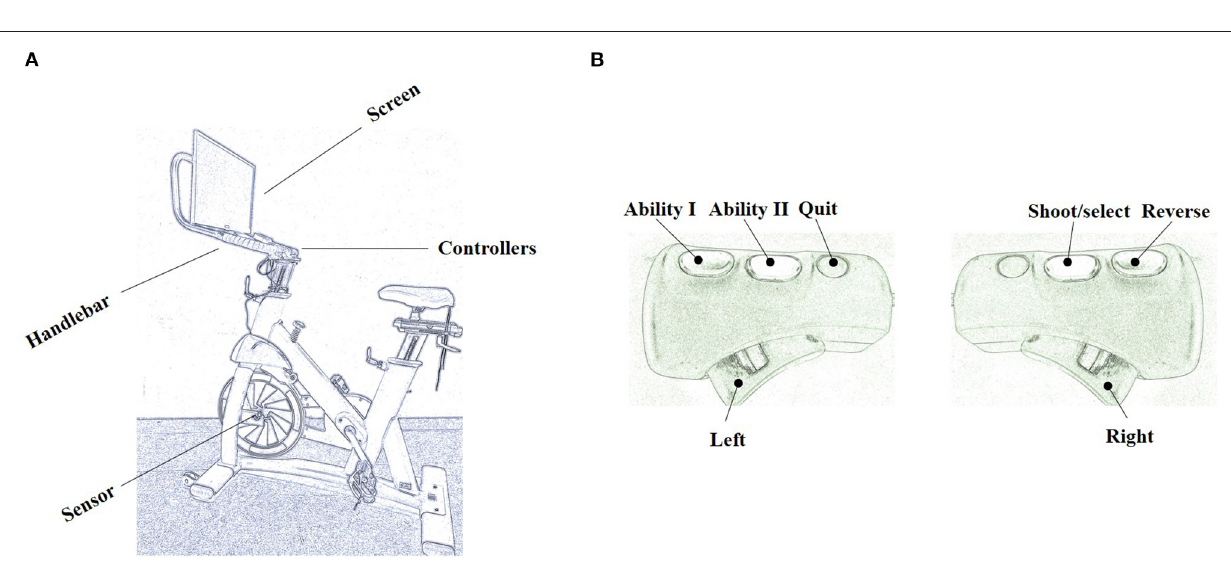
FIGURE 2 | Illustration of the exergaming platform (A) with controllers (B) used for the present study. This figure was created with